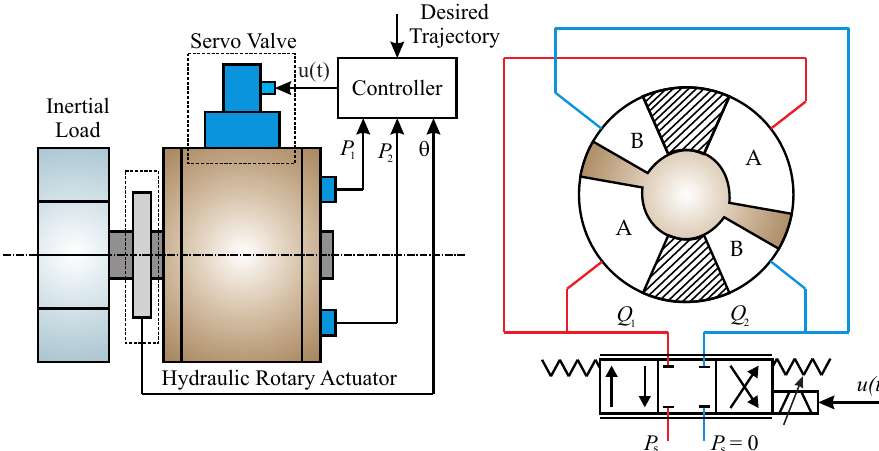
Figure 1. The structure of the studied servo valve-controlled electro-hydraulic